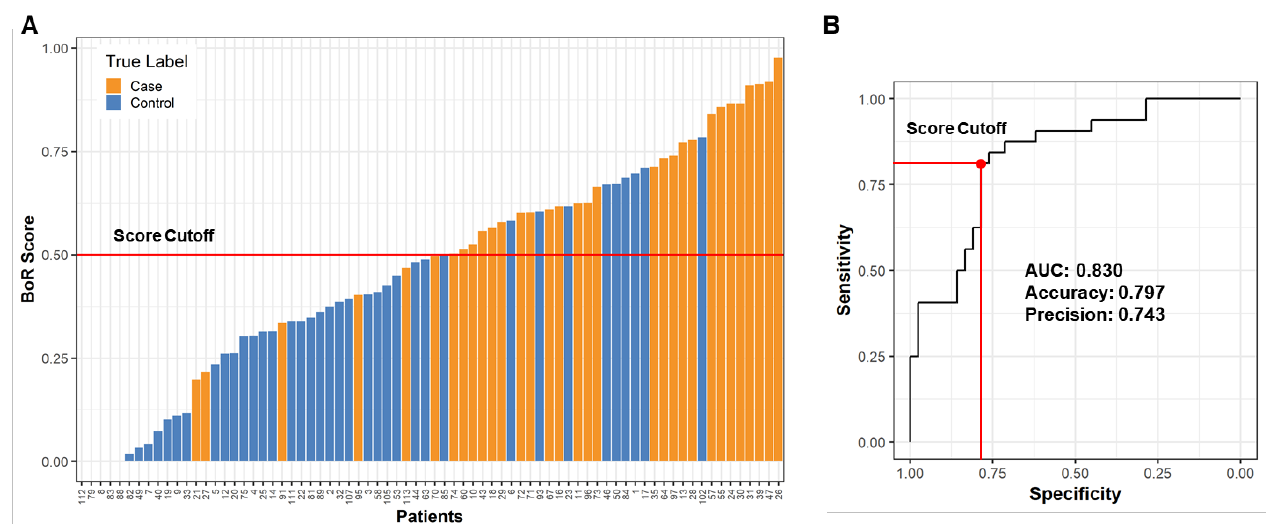
Figure 5. Olaris BoR score has high accuracy to classify male LRRK2 PD. ( A ) Waterfall plot of BoR score for all data with predicted cases scoring over 0.5 and predicted controls scoring under 0.5. True cases are colored orange and true controls are colored blue. ( B ) Receiver operator characteristic (ROC) analysis with 0.830 area under the curve (AUC). Red lines mark corresponding 81.3% sensitivity and 78.6% specificity using a score cutoff at 0.5.